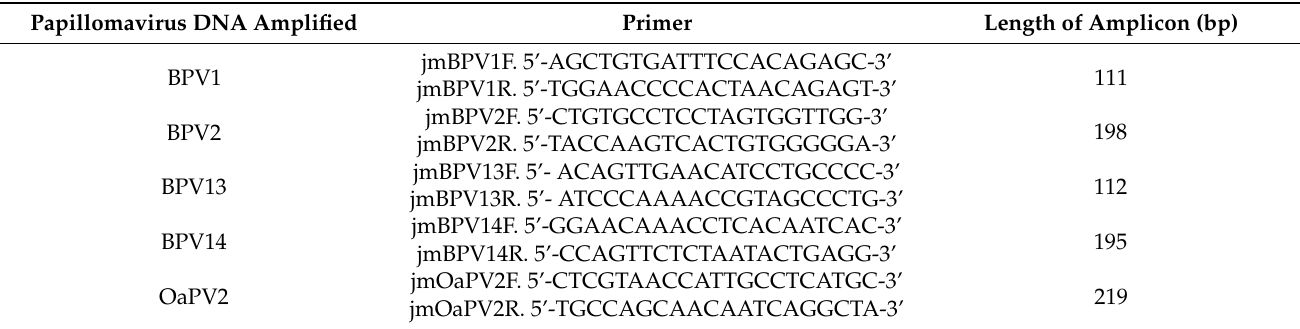
Table 1. The primer sequences used to amplify the five deltapapillomavirus types in this study. BPV is bovine papillomavirus and OaPV is Ovis aries papillomavirus. Papillomavirus DNA